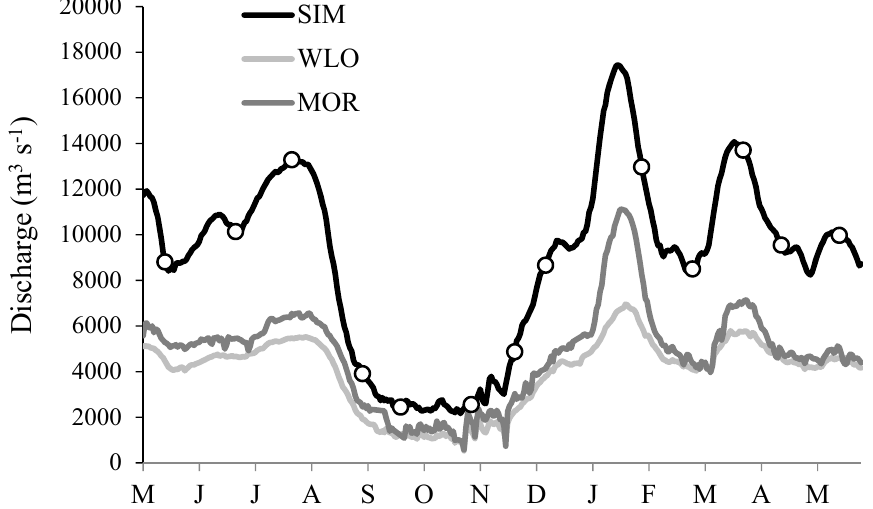
Figure 2. Daily discharge at Simmesport (inflow, SIM), Wax Lake Outlet (outflow, WLO), and Morgan City (outflow, MOR) from May 1, 2015–May 31, 2016. Markers indicate discharge at Simmesport during each sampling event. Discharge data were obtained from the USGS National Water Information System Web Interface (http://waterdata.usgs.gov/nwis).